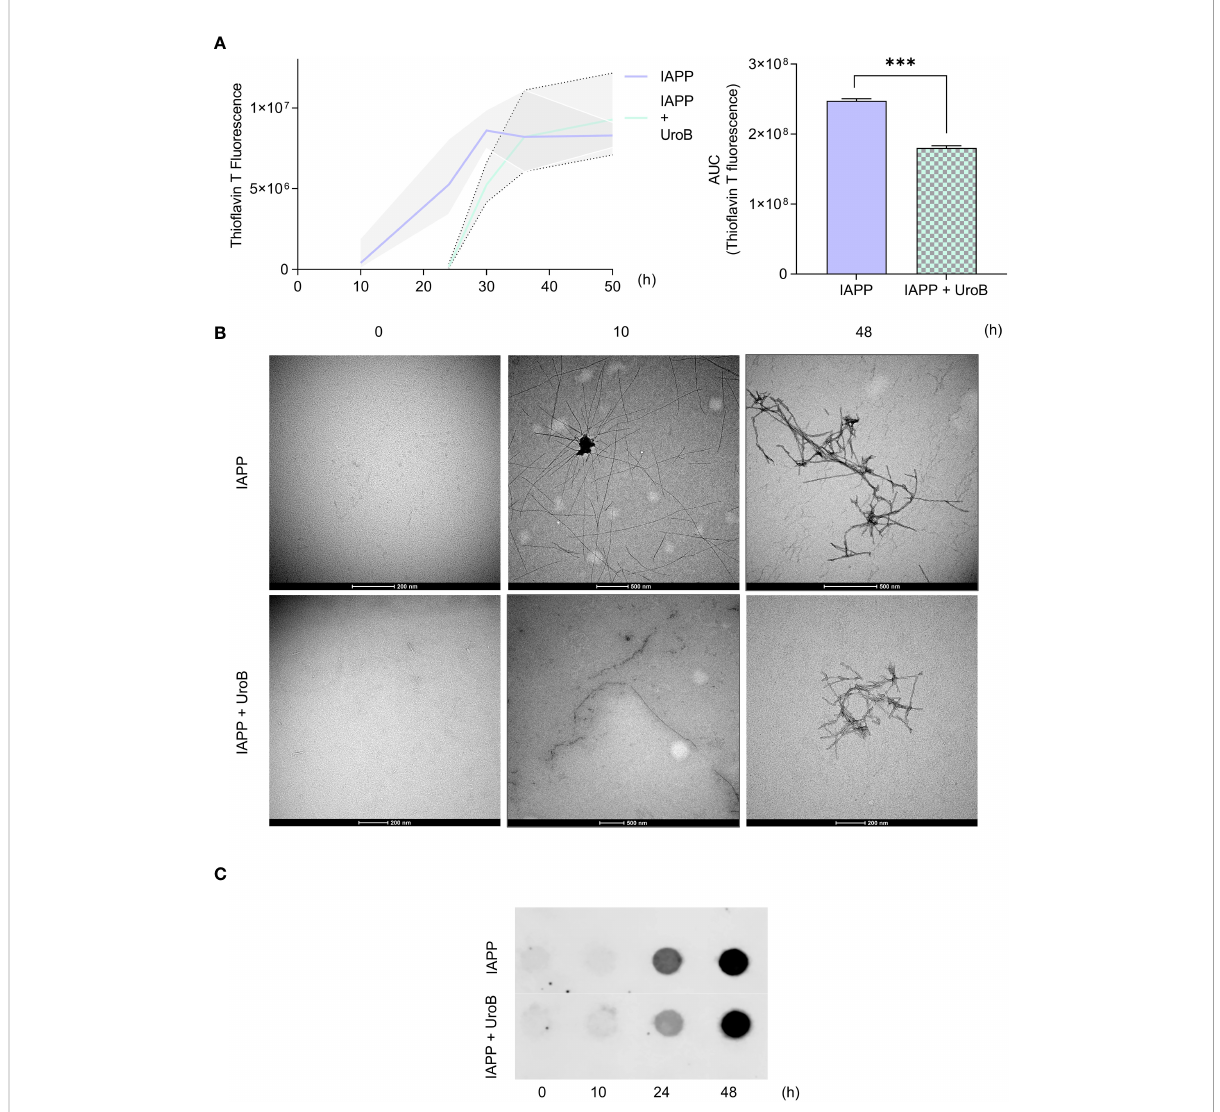
FIGURE 2 Urolithin B alters the size and structure of IAPP aggregates in cell free system. (A) Thio fl avin T (ThT) staining of 20 µM pure IAPP protein aggregation with or without 50 µM urolithin B (UroB) shows different aggregation patterns (left panel). Area under the curve of ThT curves (right panel). The values represent mean ± SD from at least three independent experiments. Statistical differences are denoted as *** p < 0.001 vs. the control condition. (B) Transmission Electron Microscopy of pure IAPP aggregated in the presence or absence of UroB. (C) Filter trap assay of samples taken from IAPP aggregation at the indicated time points. Representative images are